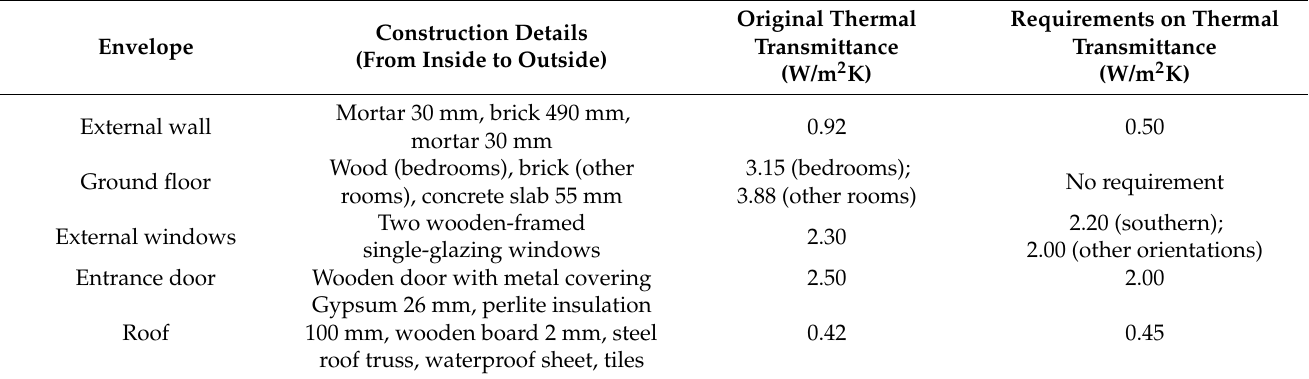
Table 1. Construction details and thermal transmittance of original envelope and the current re- quirements from the standard for newly built rural houses.